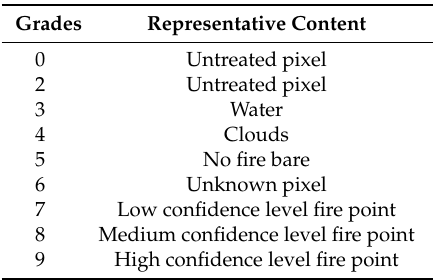
Table 1. The classifications of MOD14A1/MYD14A1 data set. Grades